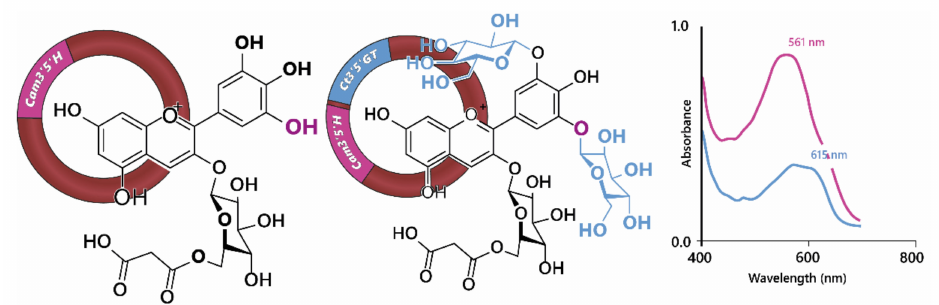
Figure 8. Noda et al., [33] achieved blue colours in chrysanthemum through the expression of Cm3’5’H (flavonoid 3’,5’- hydroxylase) and Ct3’5’GT (UDP—glucose/anthocyanin 3’,5’- O -glucosyltransferase). Hydroxylation of cyanidin 3- O -(6”- O - malonyl) glucoside at 5’ was not sufficient to generate blue colours, requiring the addition of two glucose groups to the B-ring, demonstrated by the shift in visible λ max shown on the